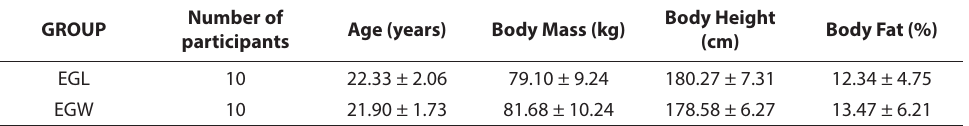
TABLE 1 Descriptive statistics of participants’ anthropometric status